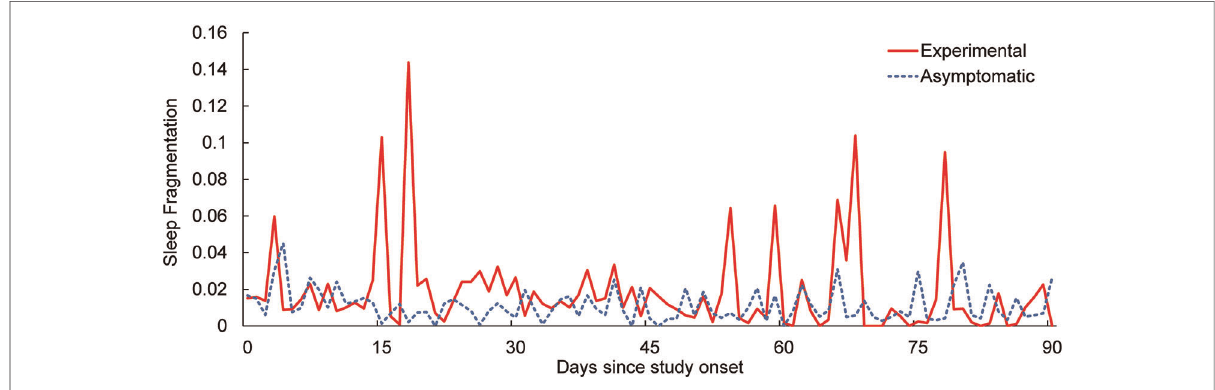
FIGURE 2 Daily average sleep fragmentation over the course of the study for the experimental and asymptomatic